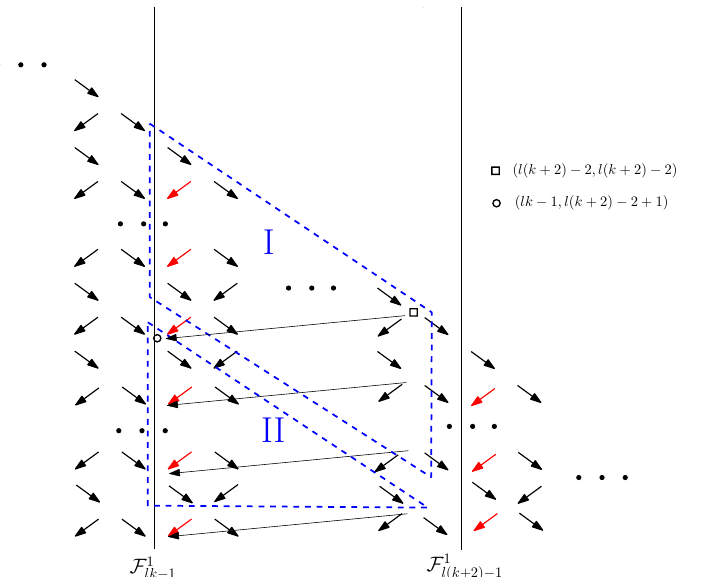
Figure 7. By square and circle we denote points, where long steps first appear. Regions I and II highlighted with blue dashed lines correspond to cases N ≤ M + 2 l − 2, as in (9), and M + 2 l ≤ N ≤ l ( k + 4 ) − 2, as in